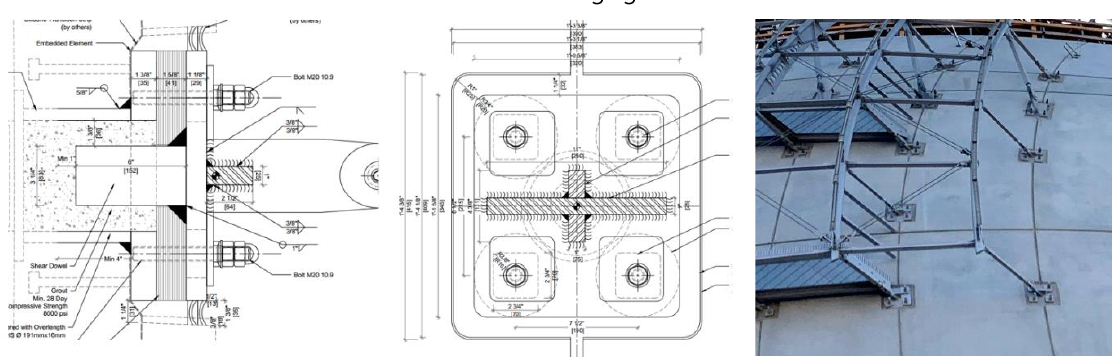
Figs. 8, 9, 10 Embed design for typical support struts, vertical section (left), front elevation (center) and as-built detail (right,). All drawings and image: Knippers